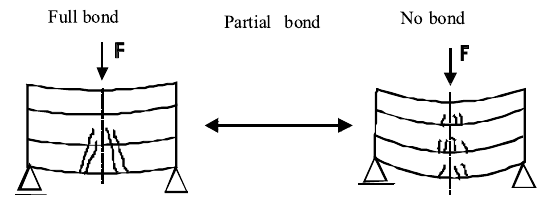
Fig 1. Redistribution of stresses in a single multilayered system due to the loss of adhesion between the